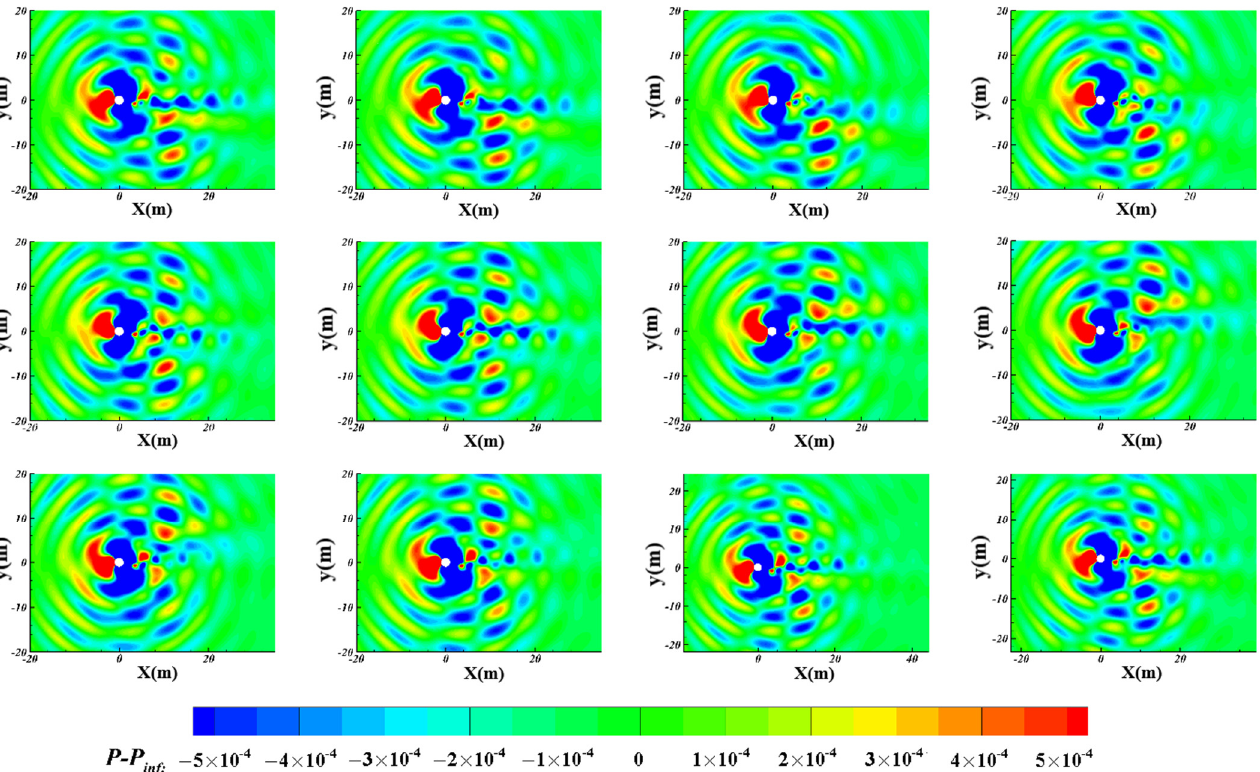
Figure 13. The Z vorticity distribution of the y = 0 line at the same time.